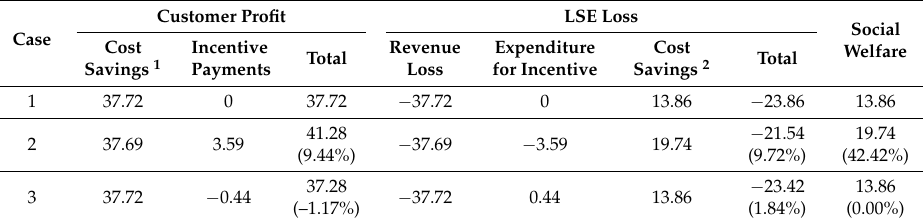
Figure 13. ESS charging schedule in Case 2 on Day 3.